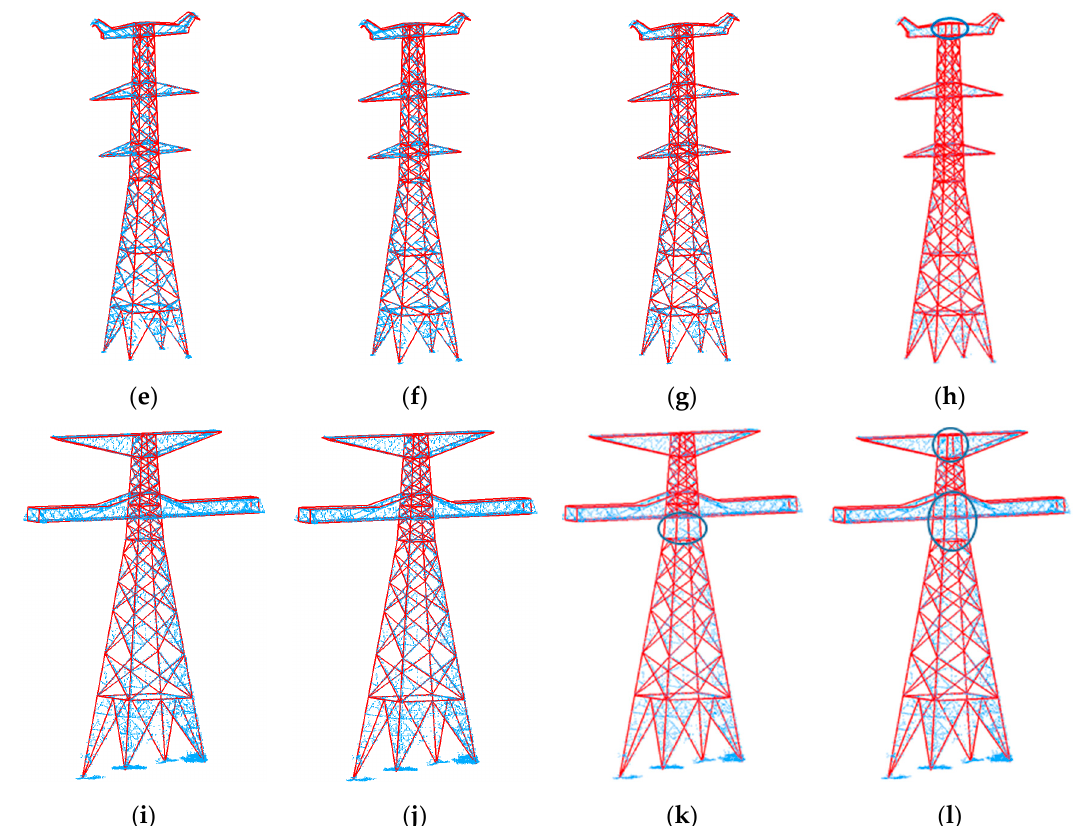
Figure 27. The result of pylon reconstruction with different point densities: ( a,e,i ) The 3D model of original point cloud of type-a, type-c, and type-d pylon; ( b,f,j ) the 3D model of sampled data of type-a, type-c, and type-d pylon with a sampling distance of 0.1 m; ( c,g,k ) the 3D model of sampled data of type-a, type-c, and type-d pylon with a sampling distance of 0.2 m; ( d,h,l ) the 3D model of sampled